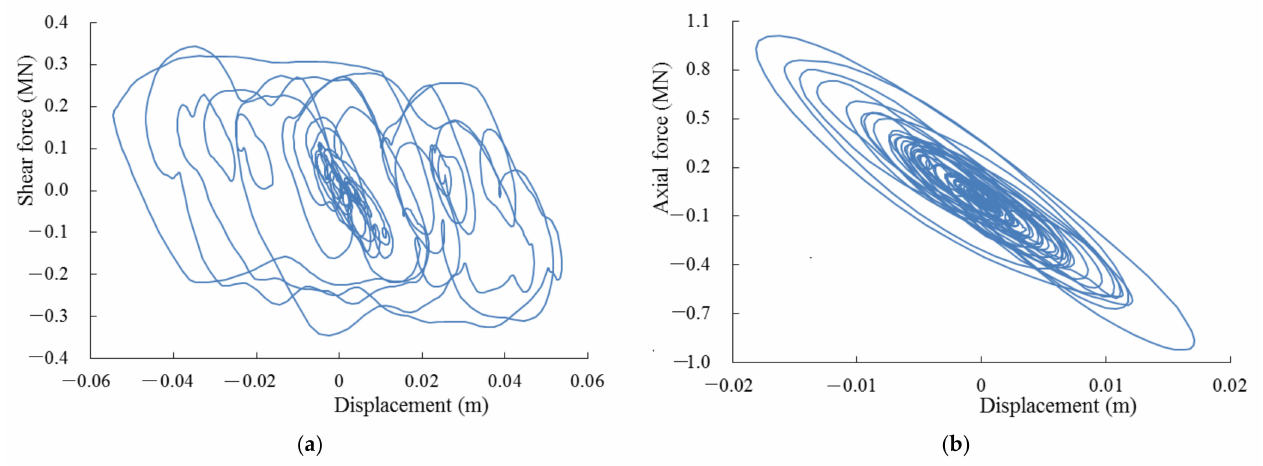
Figure 15. Hysteretic shear and axial force-displacement response of central 3D-CIB. ( a ) In the horizontal direction X ; ( b ) In the vertical direction Z